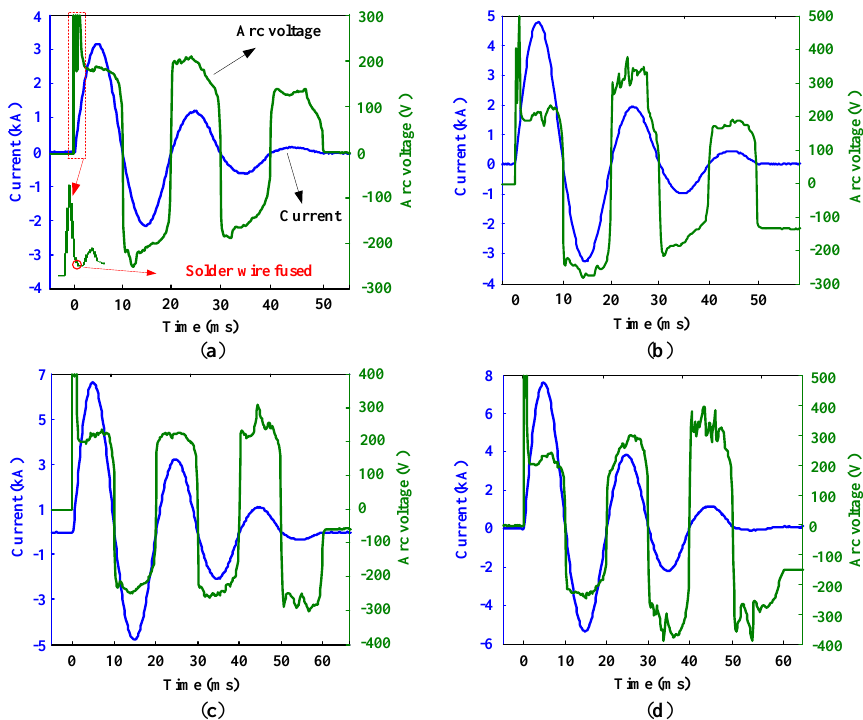
Figure 9. Signals of current and arc voltage under different charging voltages. ( a ) 3 kV; ( b ) 4.35 kV; ( c ) 6 kV; and ( d ) 6.8 kV.